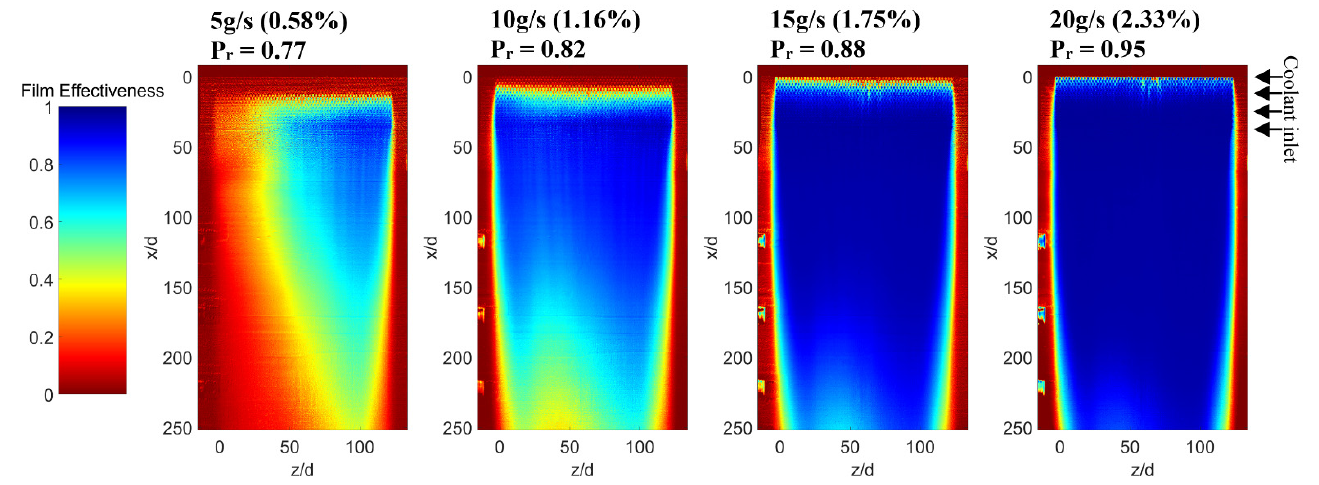
Figure 9. Film effectiveness of Panel 7 at different coolant mass flow rates (mass fraction).